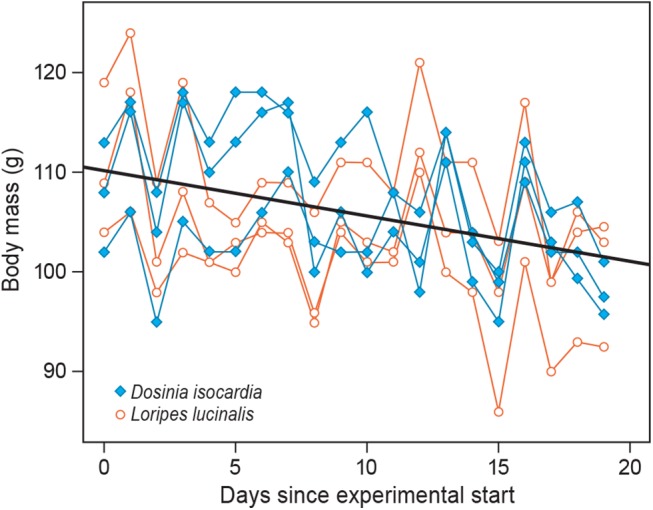
Daily body mass throughout the experiment.Individual data are connected and diet is given in legend. Thick straight line represents mixed-effect model fit.